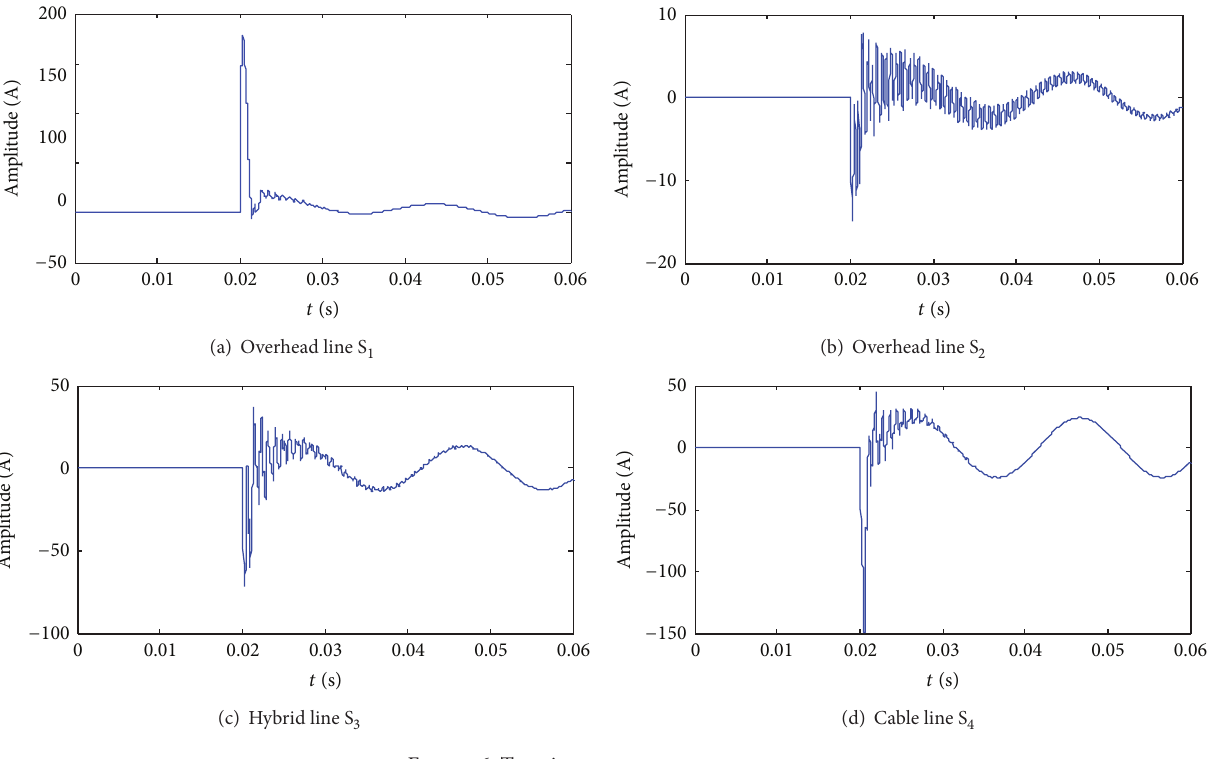
Figure 6: Transient zero-sequence current.